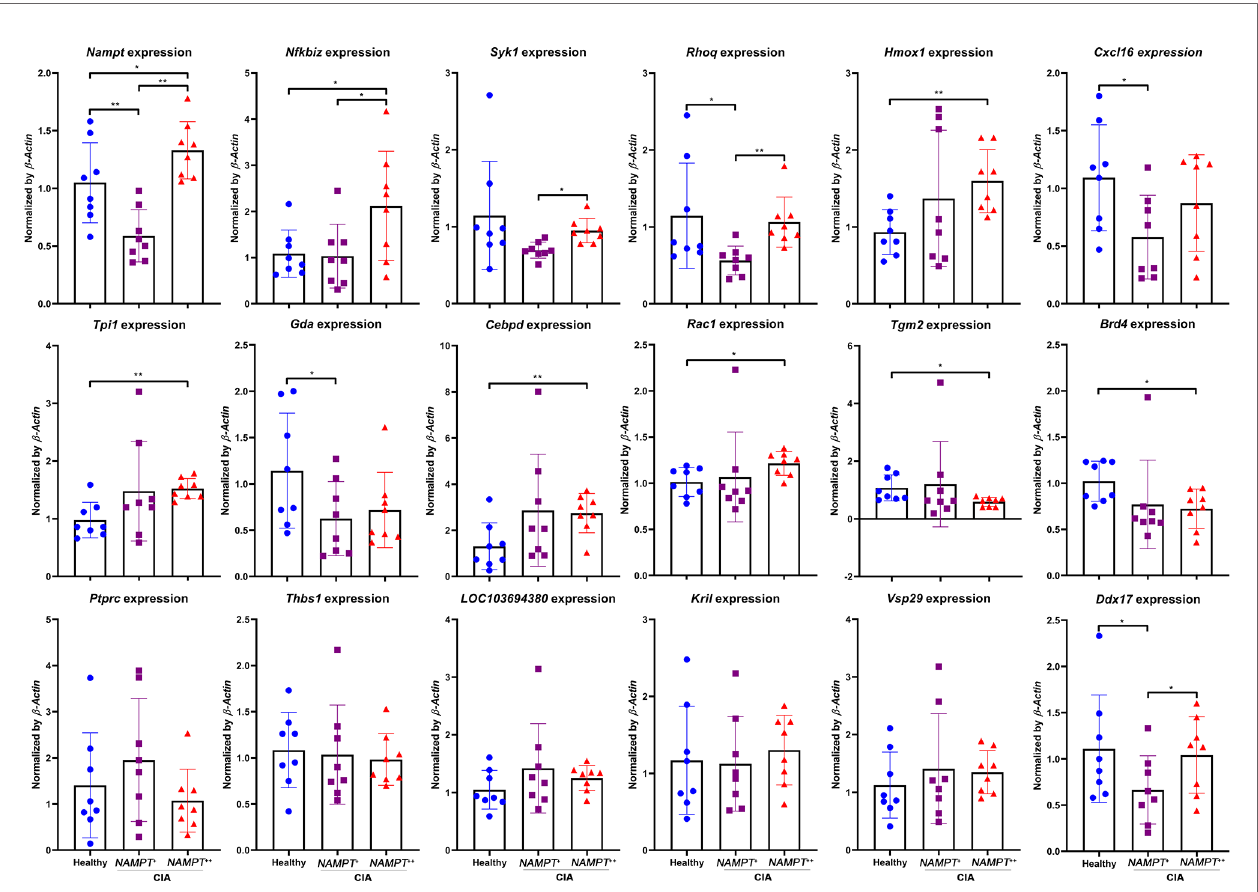
FIGURE 5 | Expression of previously identi fi ed differentiation genes in WBCs isolated from either healthy or CIA rats on day 20. CIA rats were assigned into 2 subgroups according to relative Nampt expression. The statistical signi fi cance p values < 0.05* or 0.01** were calculated between groups matched by